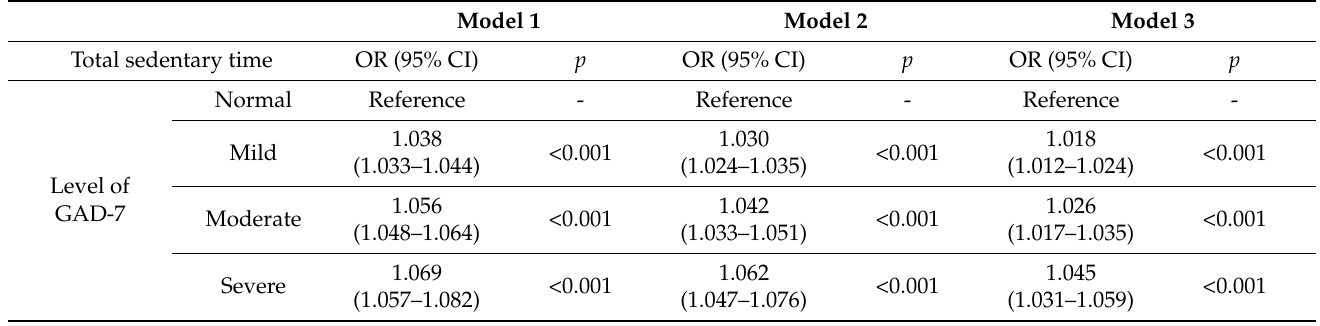
Table 6. Logistic regression analysis to level of GAD-7 disorder based on total sedentary time.